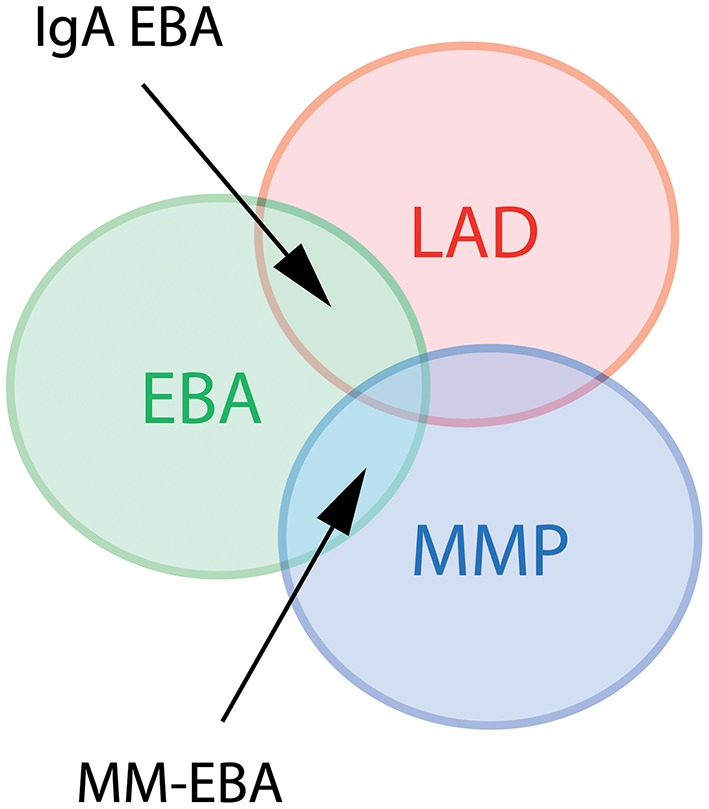
Diagram of different clinical forms of EBA. LAD, linear IgA disease. MMP, mucous membrane pemphigoid; EBA, epidermolysis bullosa acquisita; MM-EBA, mucous membrane EBA.